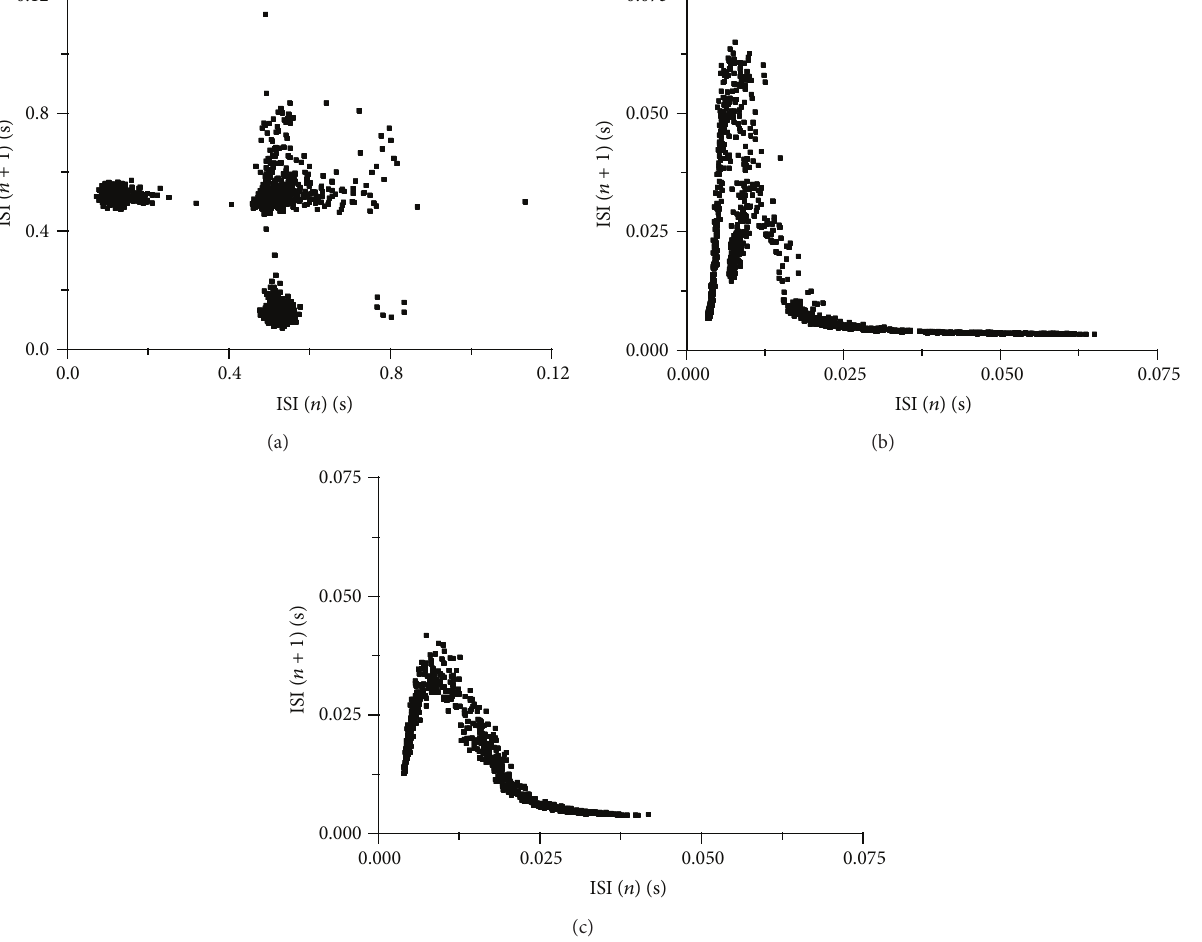
Figure 7: The first return maps of ISI series of chaotic firings within the bifurcation scenario as shown in Figure 6(a). (a) The chaotic bursting between period-1 and period-2 bursting patterns. (b) The chaotic bursting appearing after period-3 bursting patterns. (c) Chaotic